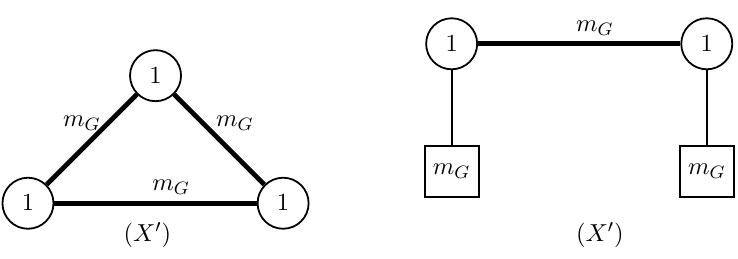
Figure 5 . The quiver gauge theory corresponding to the case with m = 3 and generic m G . The quiver on the right is obtained by decoupling a U(1) vector multiplet associated with one of the vertices of the complete graph on the